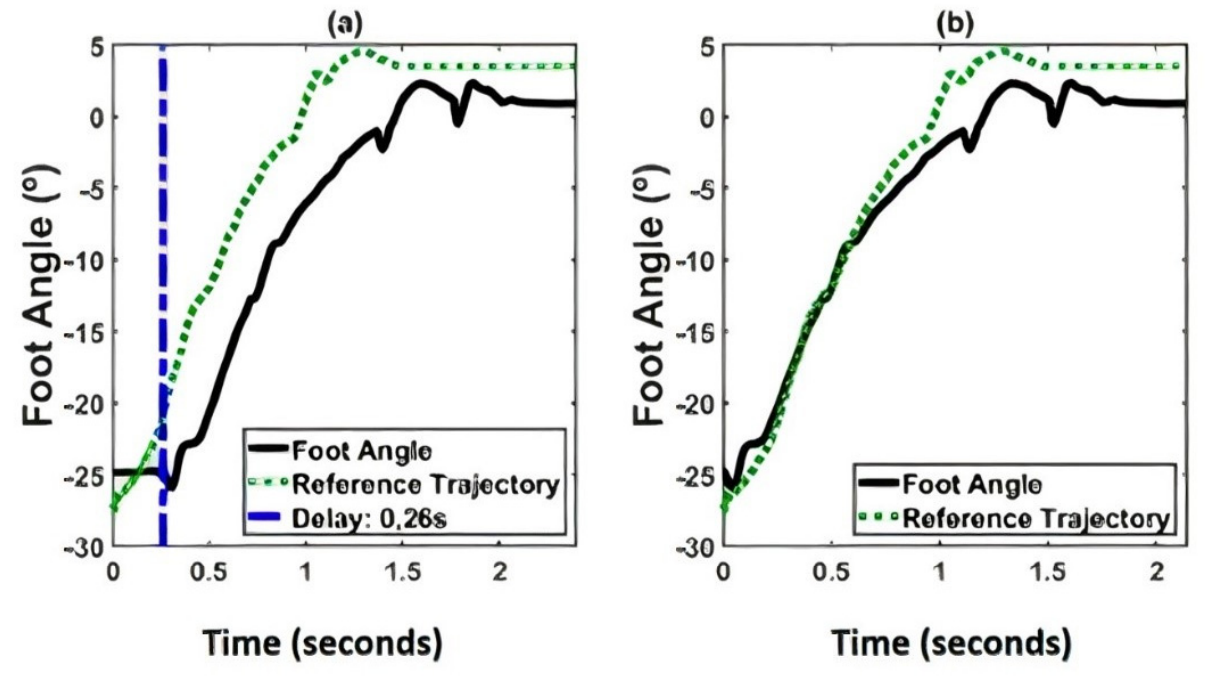
Figure 4. ( a ) Determination of the subject’s response time and ( b ) Removal of the subject’s response time. Blue line represents subject-specific time delay ( T d